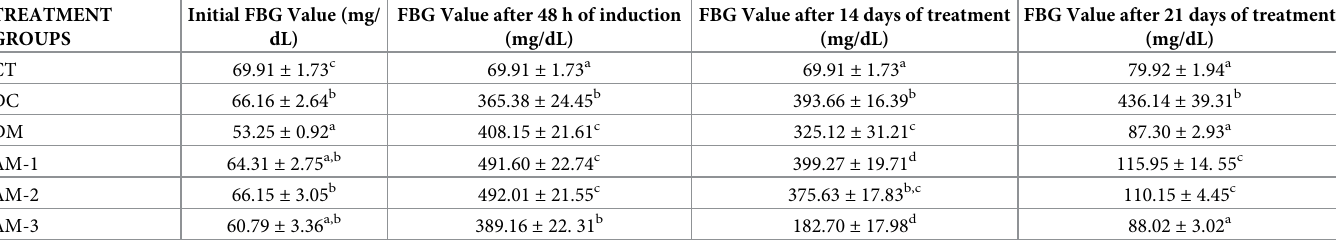
Table 2. Fasting blood glucose (mg/dL) levels of alloxan-induced diabetic rats before and after oral administration of aqueous extract of A . muricata peels. TREATMENT